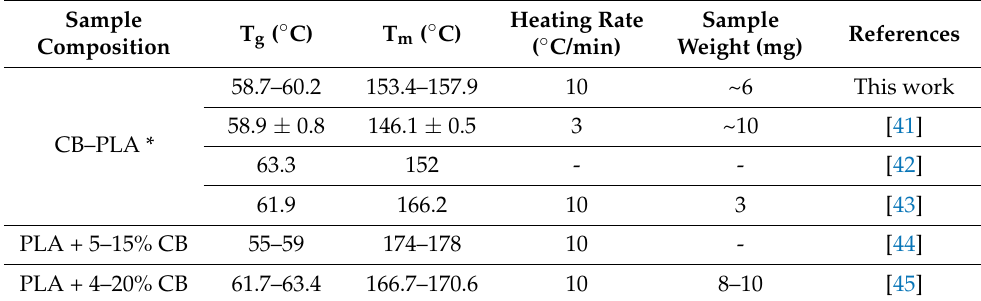
Table 3. DSC results for conductive PLA-based materials described in the